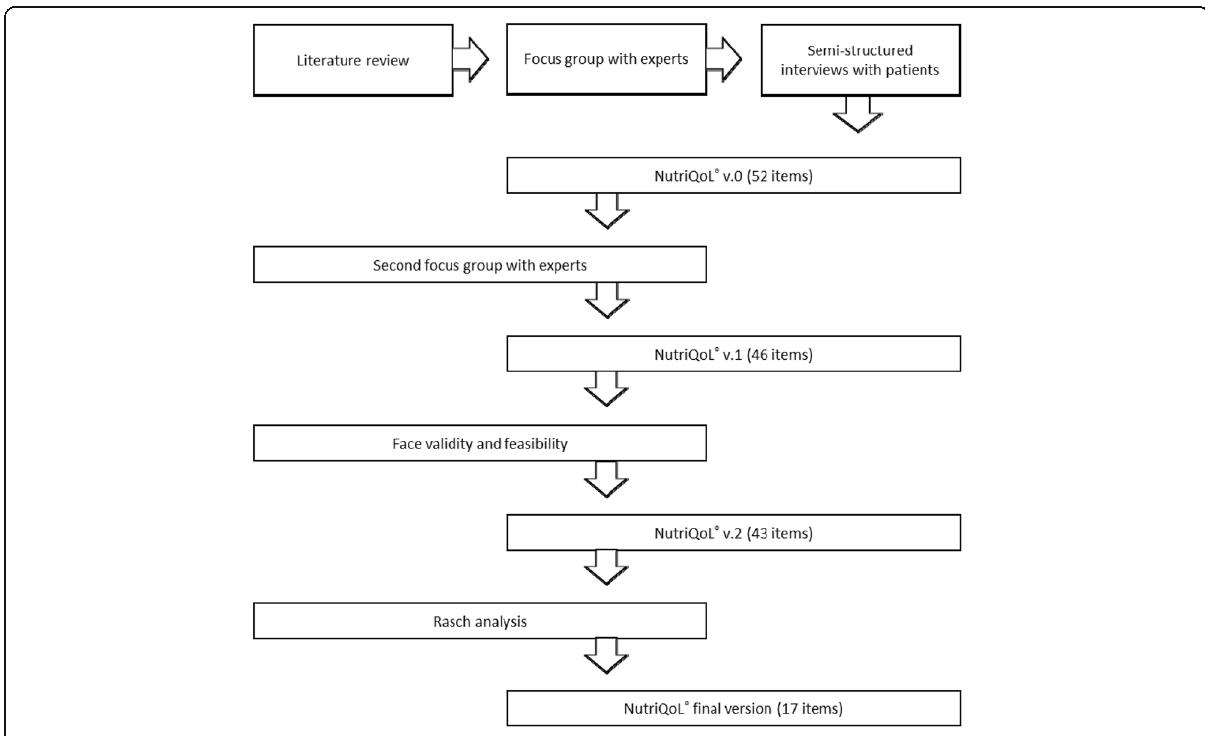
Fig. 4 Development of the NutriQoL